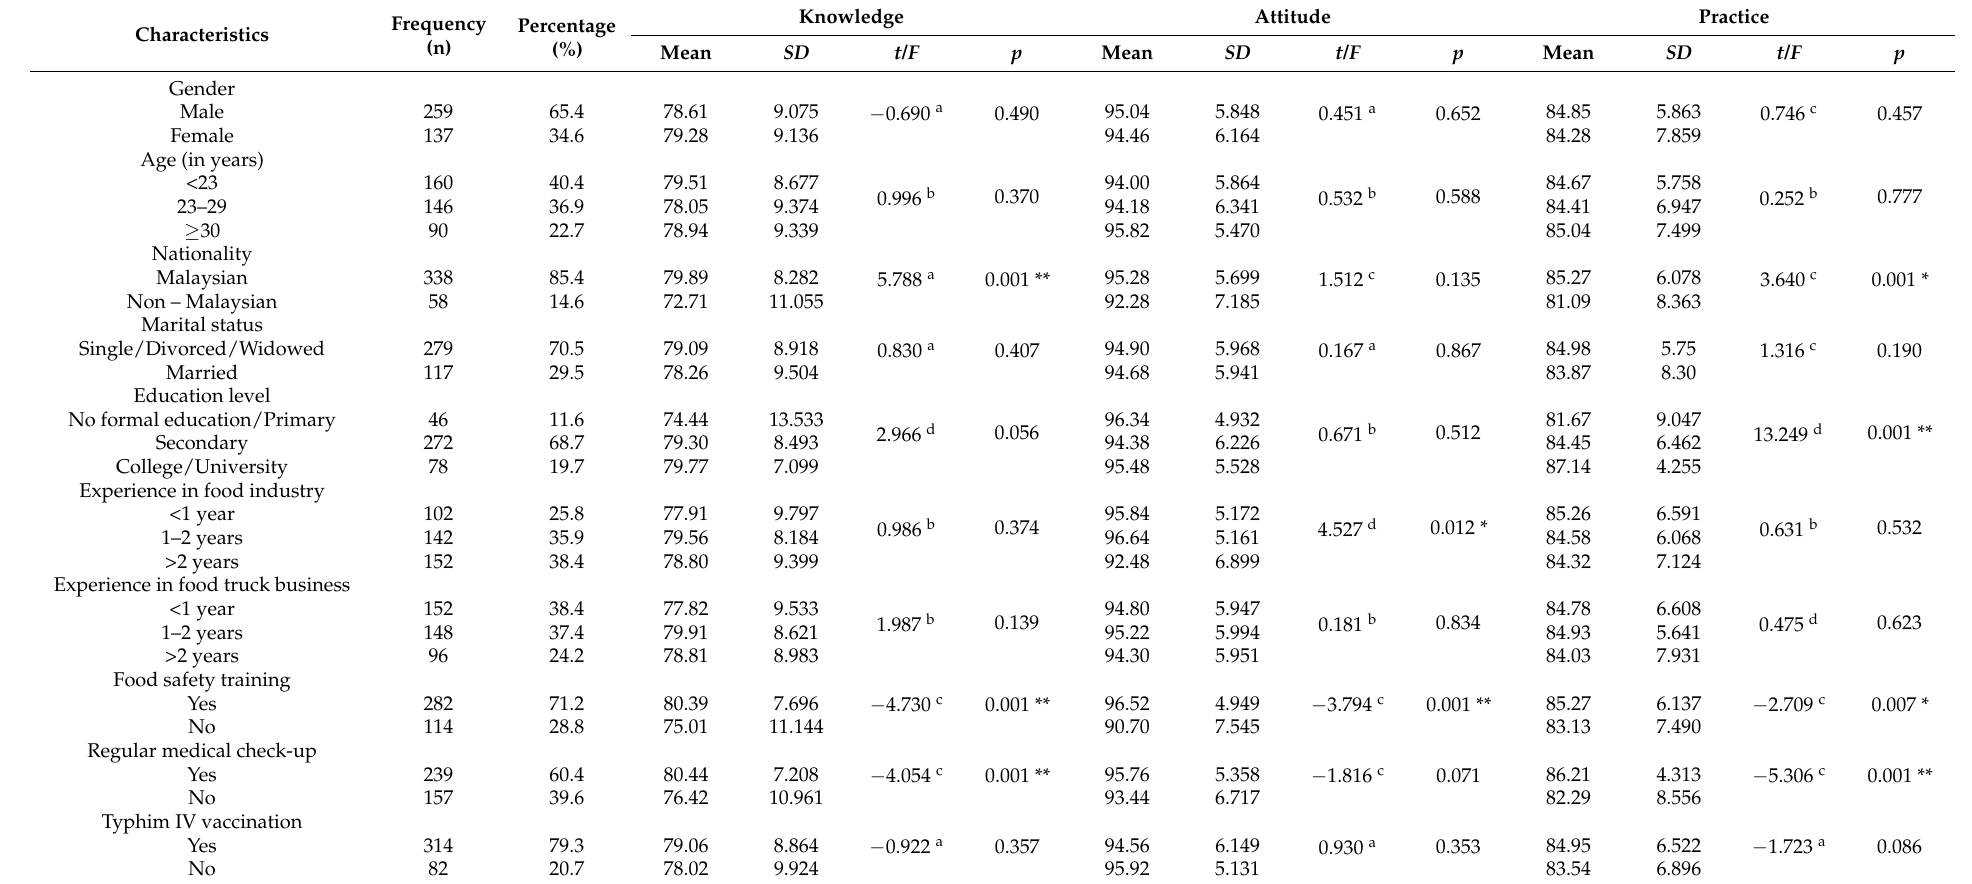
Table 2. KAP of food safety during COVID-19 pandemic according to FTVs’ sociodemographic characteristics (N = 396).